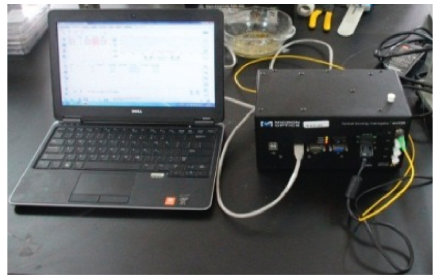
Figure 5: Grating sensor data acquisition